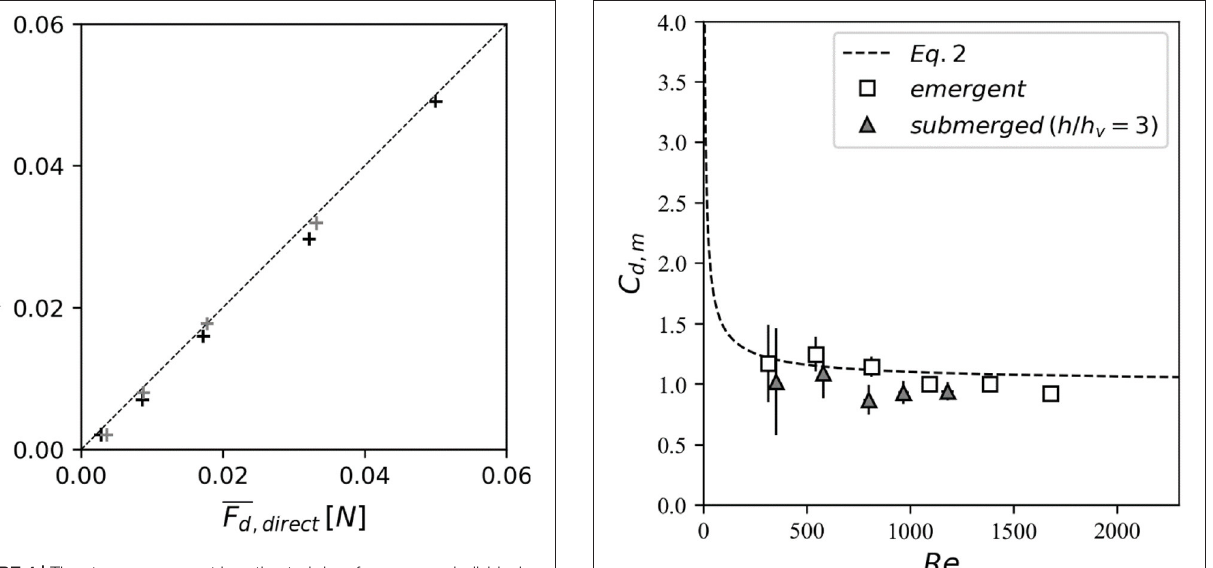
FIGURE 4 | The strong agreement in estimated drag forces on an individual element in an emergent canopy using two methods: (i) measured directly using the force sensor ( F d , direct ) and (ii) derived indirectly from the water surface gradient ( F d , momentum ). Marker color indicates canopy density (black: λ p 0.05; gray: λ p 0.10). The size of the markers indicates the associated = measurement uncertainty. The dashed line represents the line of perfect agreement.